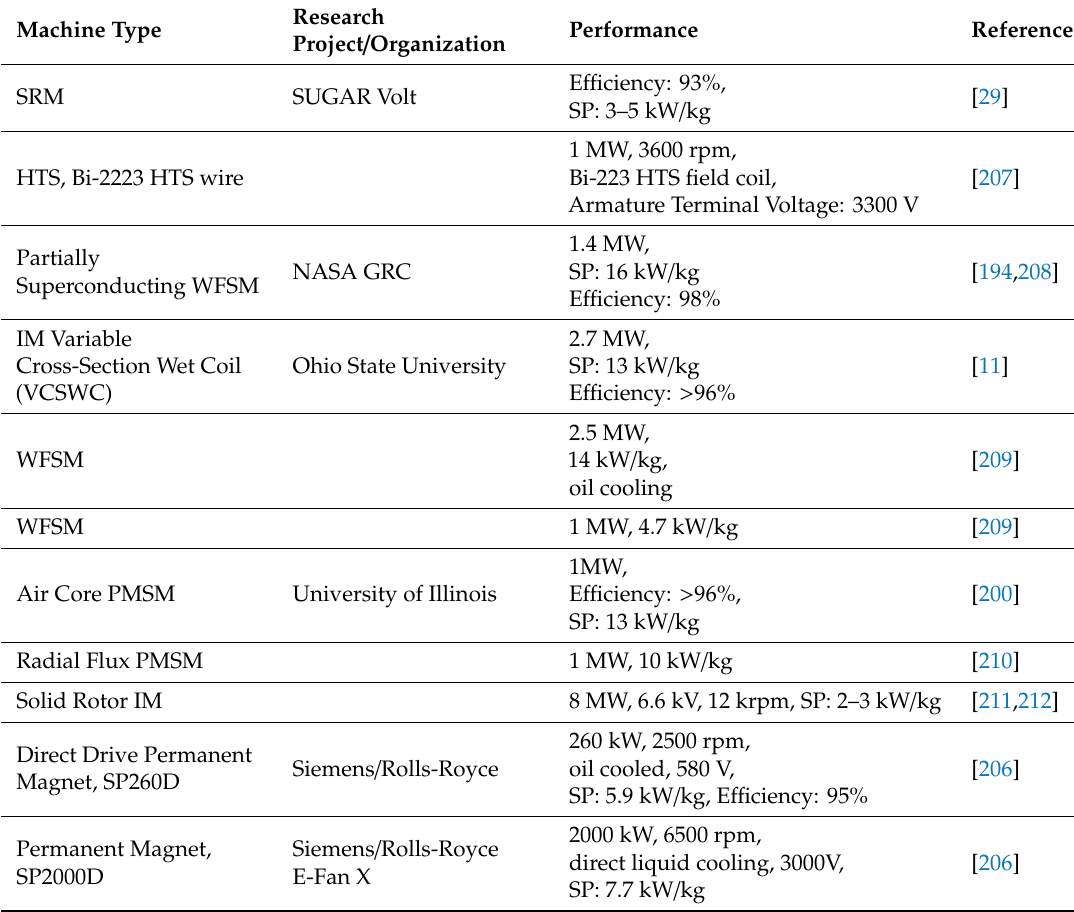
Table 5. Projection in electrical